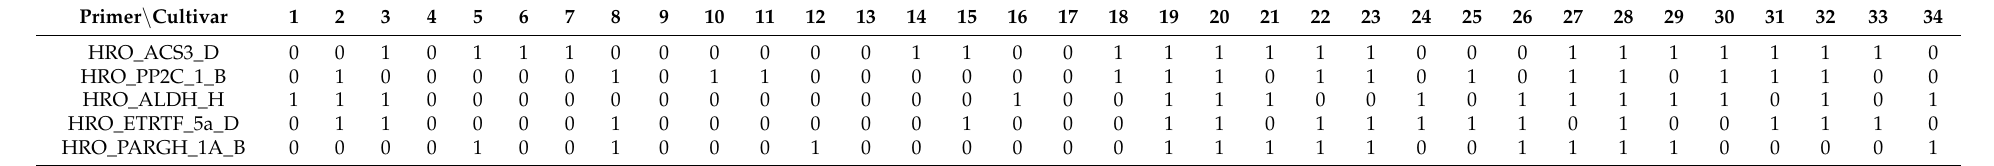
Table 1. Scoring pattern of SSR markers significantly associated with drought tolerance in potato.